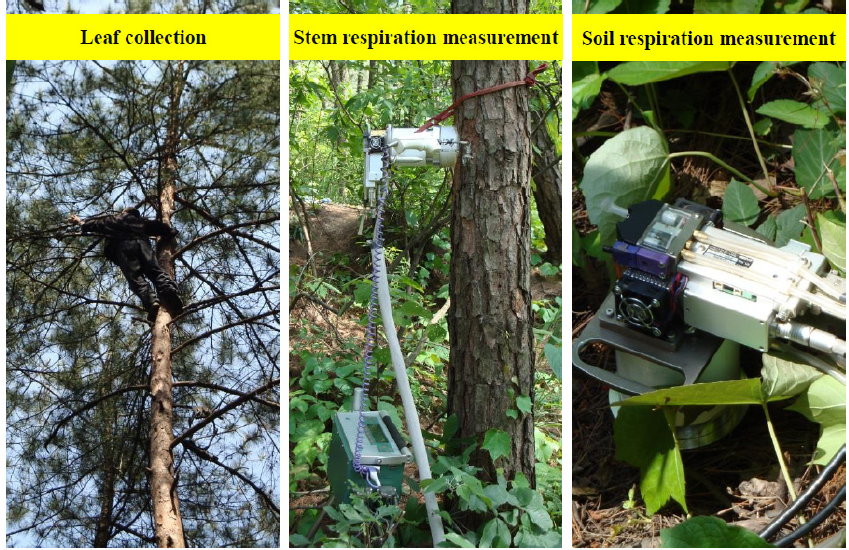
Figure 1. Field measurements of individual components, including leaf respiration, stem respiration and soil respiration, of ecosystem respiration (ER) in subtropical forest ecosystem of central China.